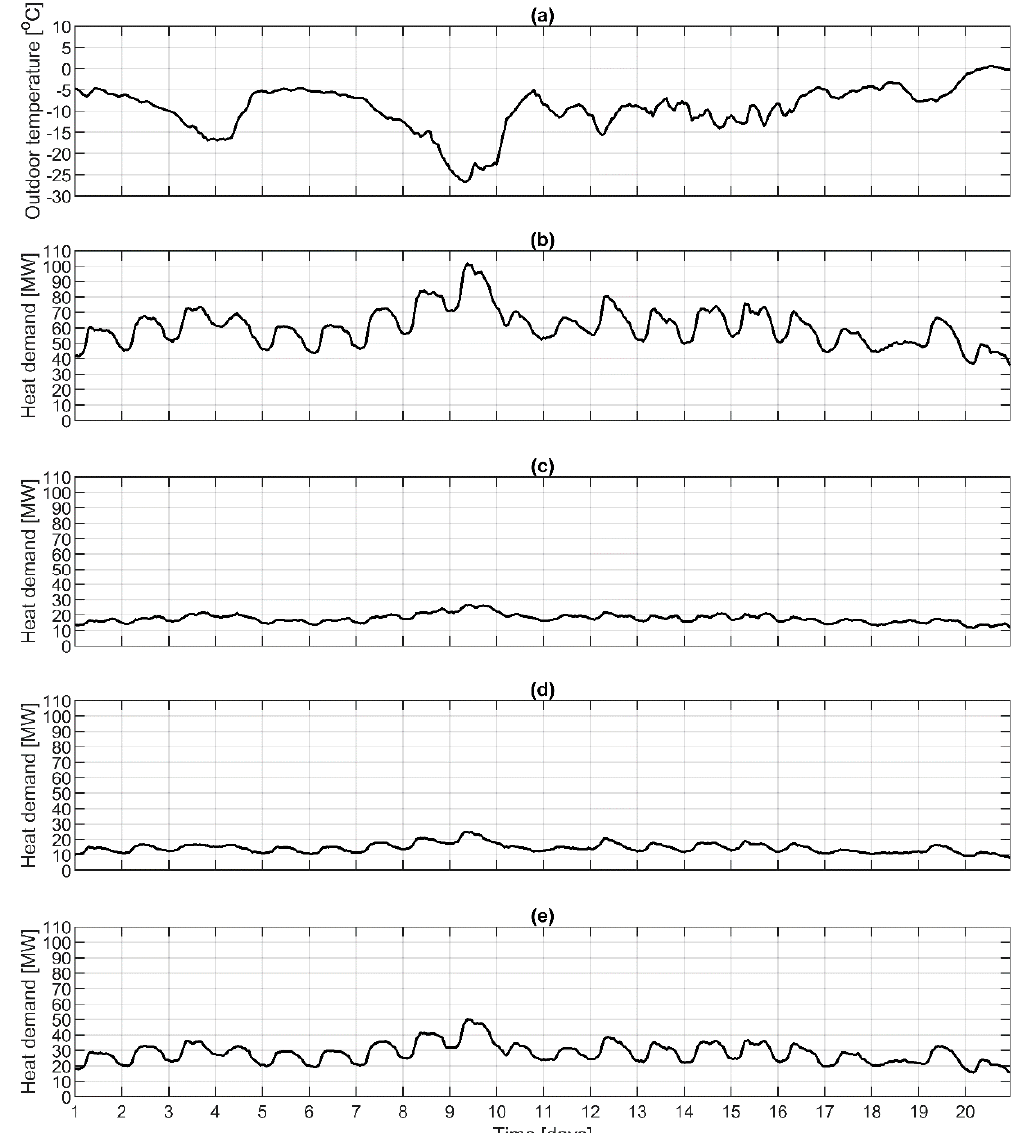
Figure 4. Measured ( a ) outdoor temperature, ( b ) the total heat demand in 201 buildings, ( c ) the total heat demand in apartment buildings, ( d ) the total heat demand in schools, and ( e ) the total heat demand in commercial, public and office buildings.